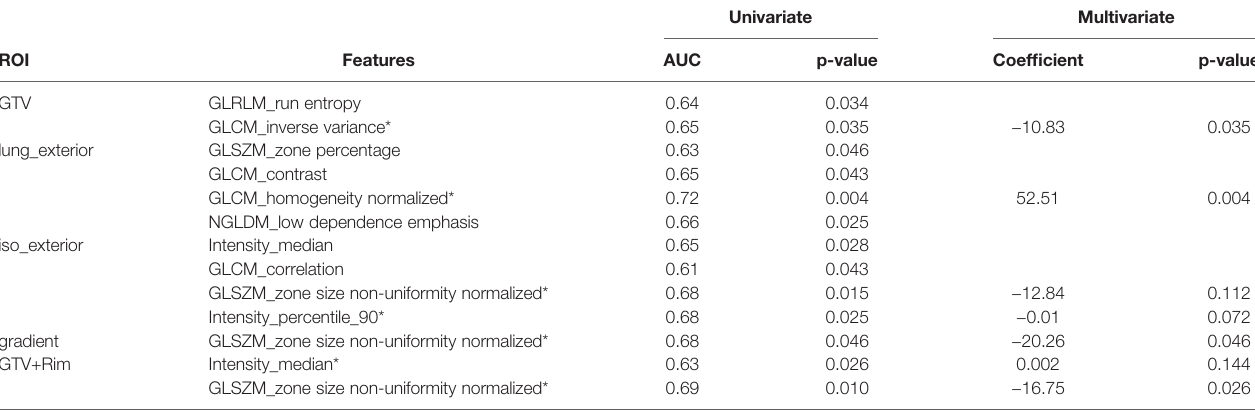
TABLE 1 | Overview of univariate and multivariate analysis shown for all region of interests (ROIs)